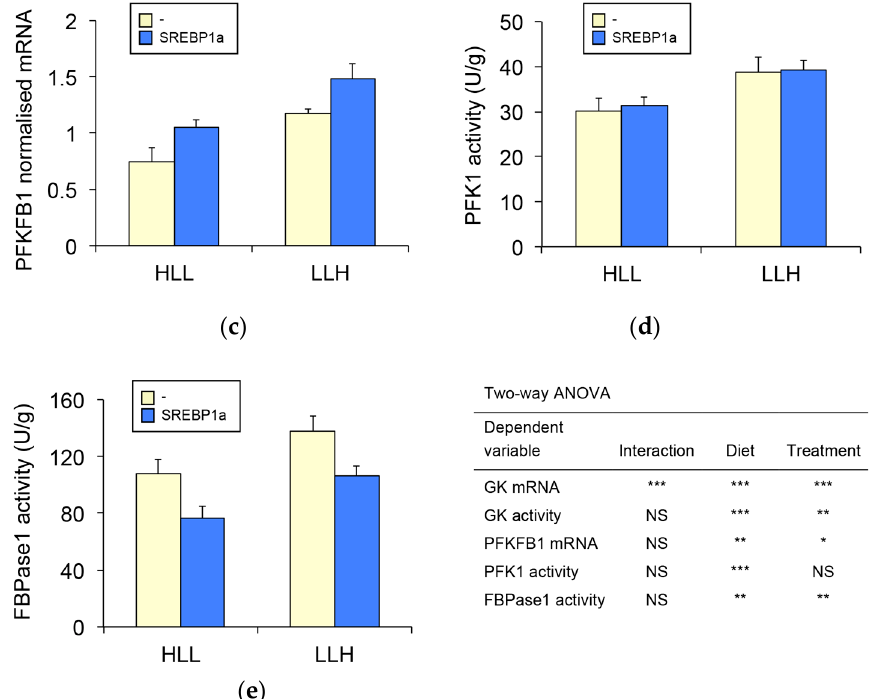
Figure 3. Effect of chitosan-TPP-pSG5-SREBP1a administration on the expression of key enzymes in glycolysis-gluconeogenesis in the liver of S. aurata . Twenty-four hours after the last meal, fish fed diet HLL or LLH were intraperitoneally administered with chitosan-TPP nanoparticles complexed with 10 μ g/g BW of pSG5 (-) or pSG5-SREBP1a (SREBP1a). Seventy-two hours post-treatment, the liver was collected and RNA isolated. Hepatic mRNA levels and enzyme activity of GK ( a , b ), PFKFB1 ( c ), PFK1 ( d ) and FBPase1 ( e ) are presented as mean ± SEM (enzyme activity, n = 8; mRNA levels, n = 6). The mRNA levels for each gene were assayed by RT-qPCR and normalised with the geometric mean of ribosomal subunit 18s, β -actin and EF1 α . Statistical significance for independent variables (diet and treatment) is indicated as follows: * p < 0.05; **p < 0.01; ***p < 0.001; NS not significant.